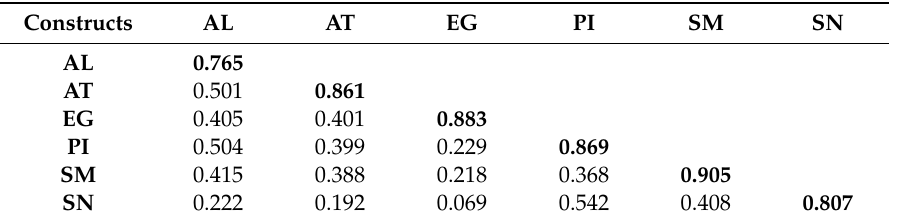
Table 4. Discriminant